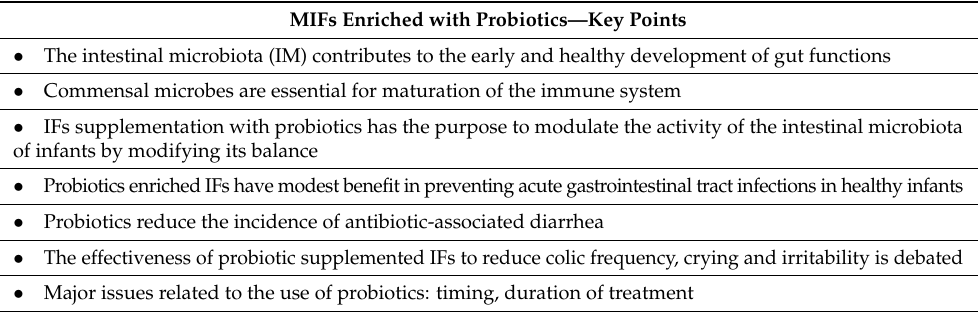
Table 2. Summary of beneficial effect of MIFs enriched with